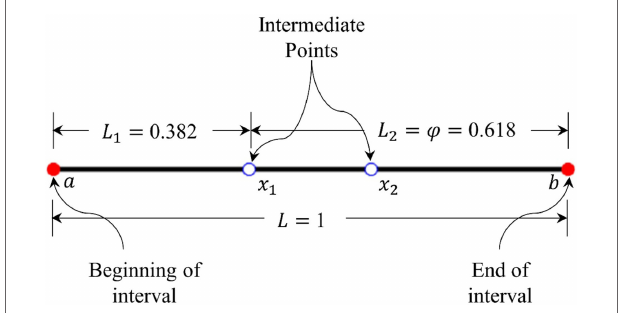
FIGURE 3 | Sections of golden section search for a unit interval.